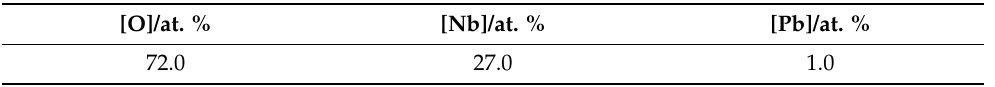
Table 3. Elemental composition modified surface layer of the LiNbO 3 single crystal from the results of the energy-dispersive X-ray spectroscopy